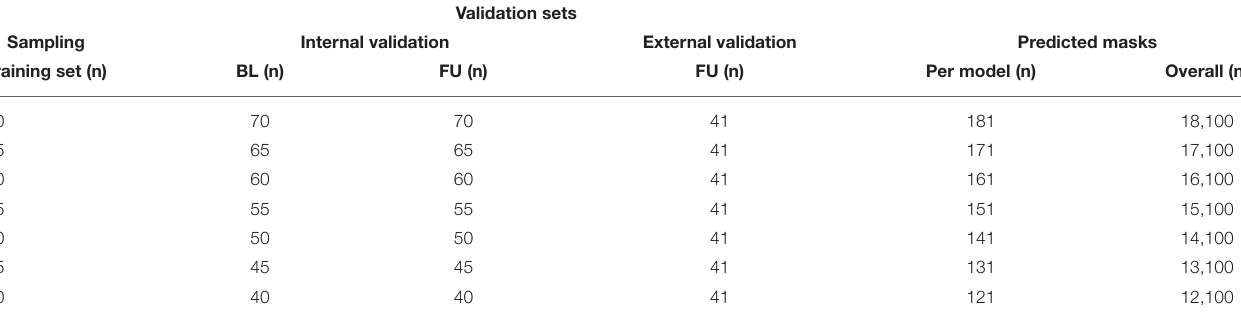
TABLE 2 | Number of observations in training and validation sets.